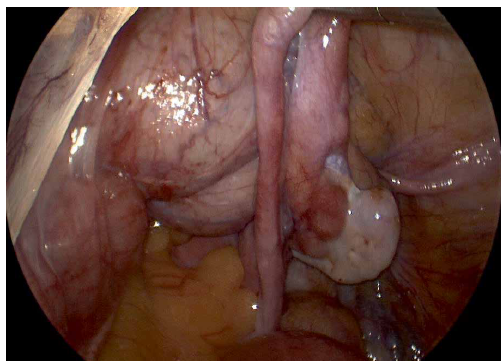
Figure 5: The tube is elevated and the fimbriae and ovary are seen to the right of the isthmus of the tube. The uterine fundus is just visible under a layer of bowel